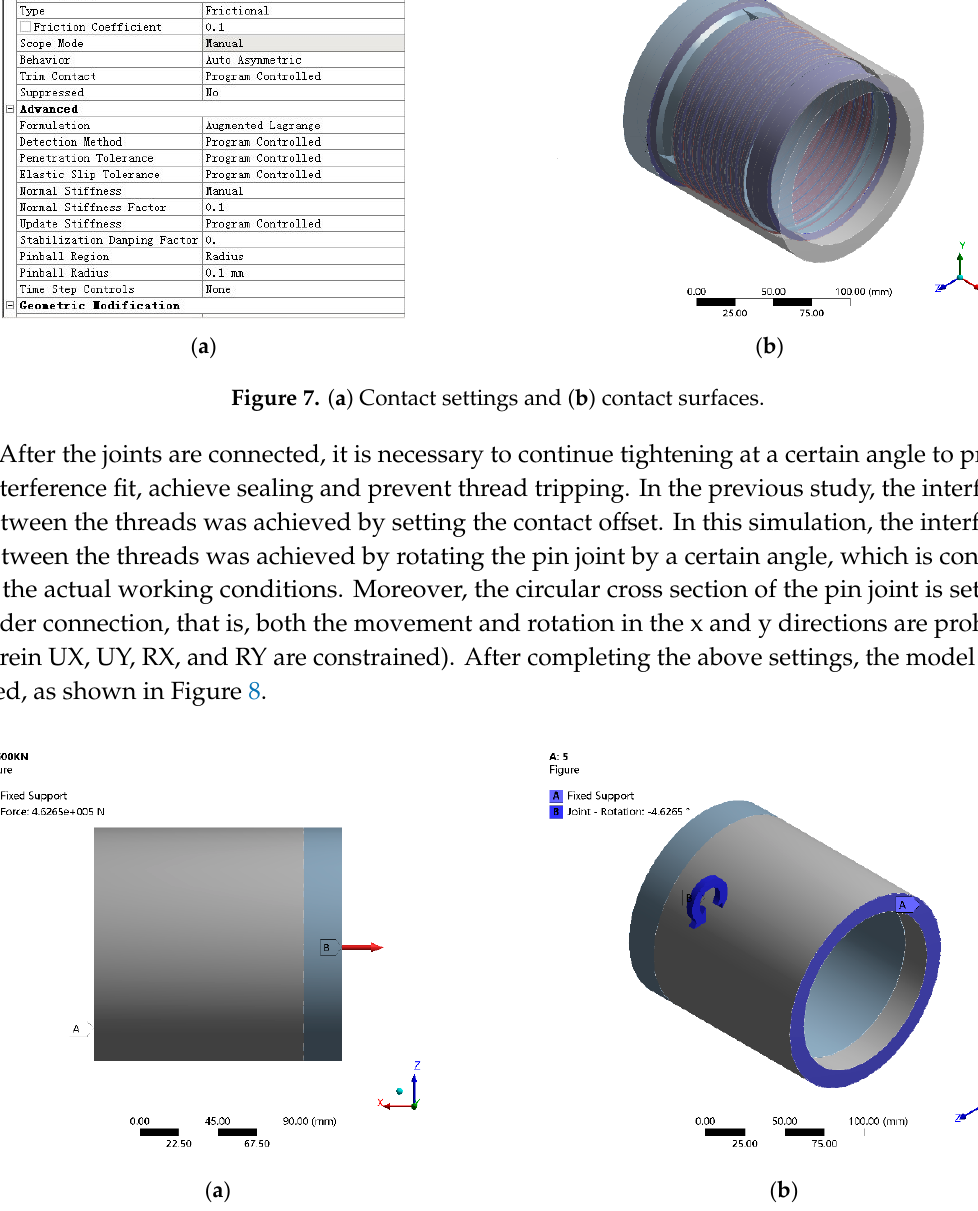
Figure 8. Loading conditions: ( a ) tensile load and ( b ) torsional load.